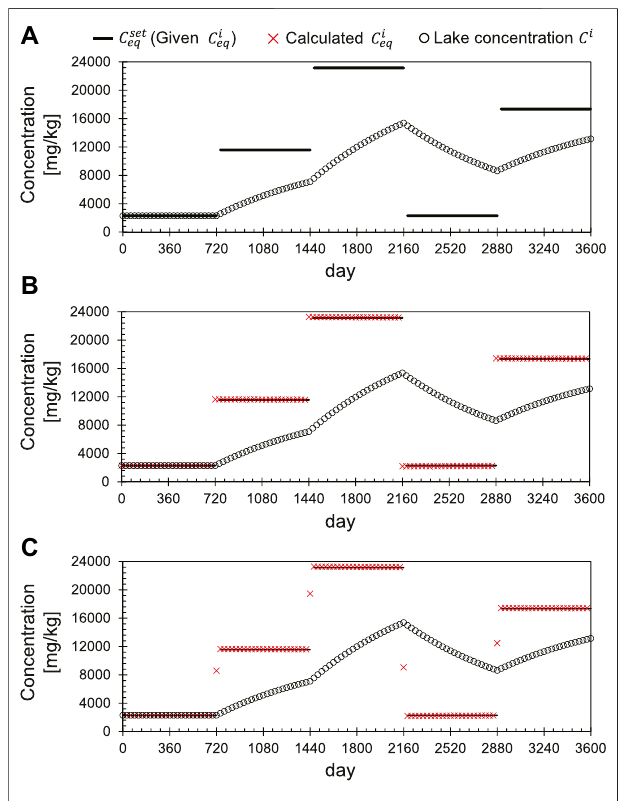
FIGURE 3 | Time-series computational test of the C i eq estimation described in Estimation of the Temporal Changes in the Steady-State Concentration C eq , assuming a (cid:2) 1,000 days, corresponds to the case of Yugama crater lake ( Table 2 ). (A) Time-series of C i (at intervals of 30 days) in response to step-like changes in C eq de fi ned as C set eq (cid:2) 2,300, 11,500, 23,000, 2,300, and 17,000 mg/ kg, as calculated by Eq. 5 . (B) Two data ( Eq. 10 ) and (C) three data ( Eq. 13 ) calculation of C i eq from C i